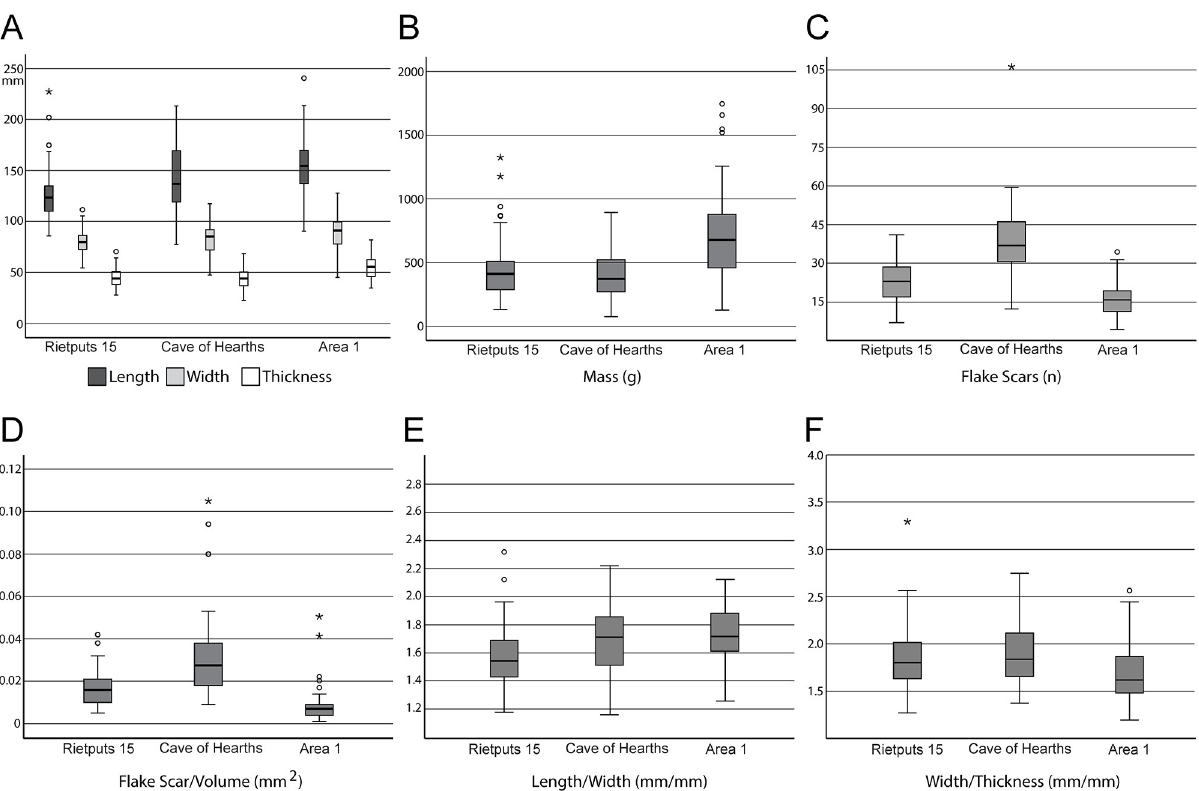
Fig 20. Comparison of Area 1 handaxes metrics with Rietputs 15 and Cave of Hearths. A) Boxplot of length, width and thickness variables; B) Boxplot of mass by grams; C) Boxplot of flake scar counts; D) Boxplot of scar density index by volume; E) Boxplot of elongation index; F) Box plot of refinement